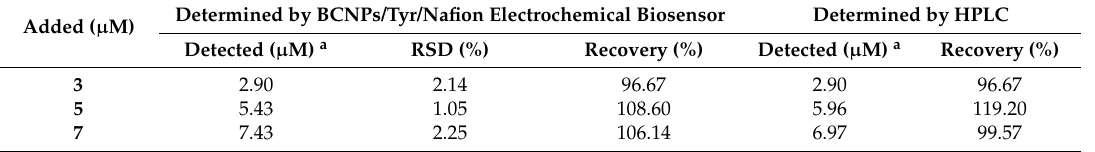
Table 1. Determination of BPA in real ground water samples using BCNPs/Tyr/Nafion/GCE biosensor and HPLC method.